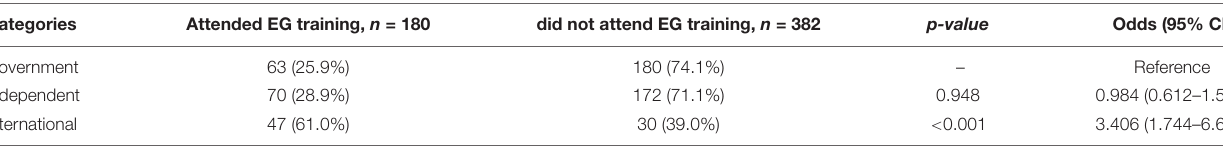
TABLE 2 | Logistic regression and OR for the school type.